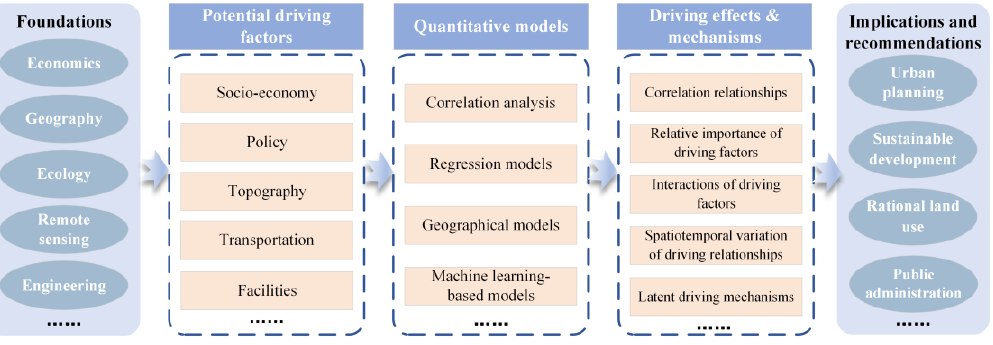
Figure 1. Road map for DAUE study.